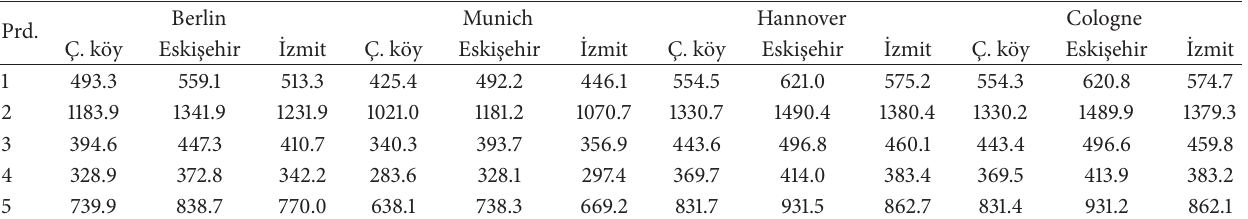
Table 1: Product based transportation costs (CTr 1 𝑝𝑖𝑙𝑎 ) from manufacturing facilities in Germany to local warehouses in Turkey (TL/product unit).